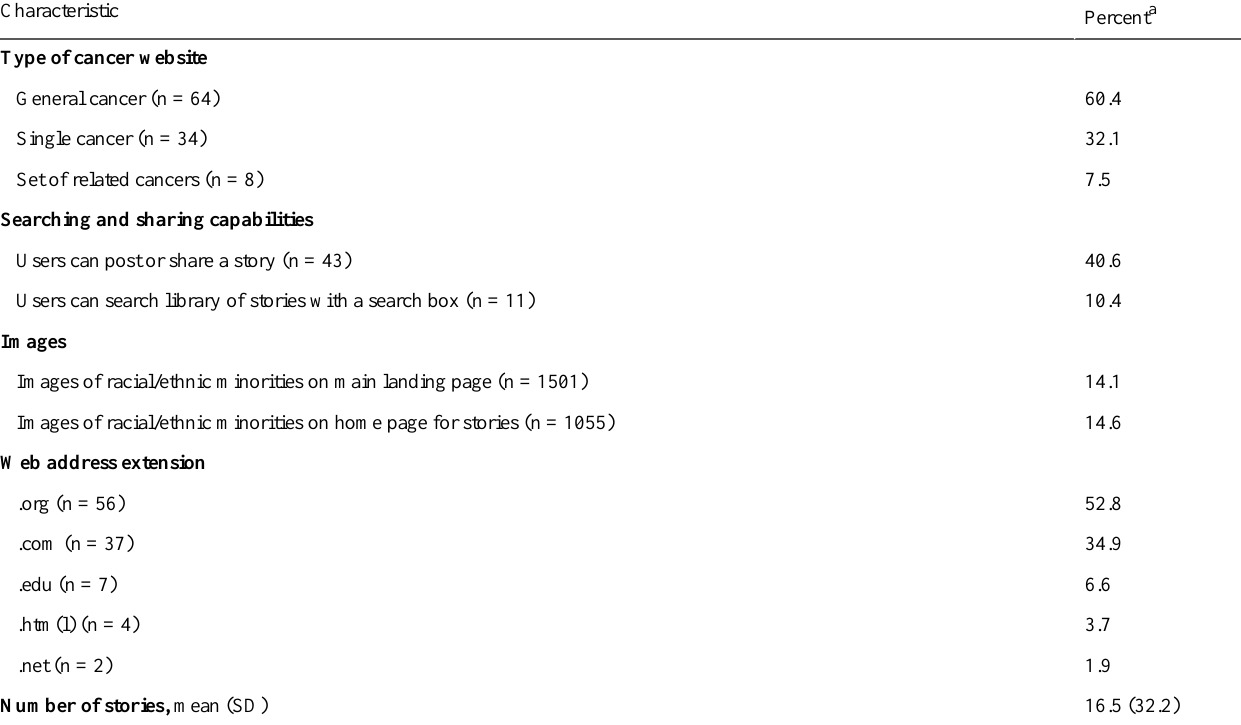
Table 1. Characteristics of websites containing cancer survivor stories (n =